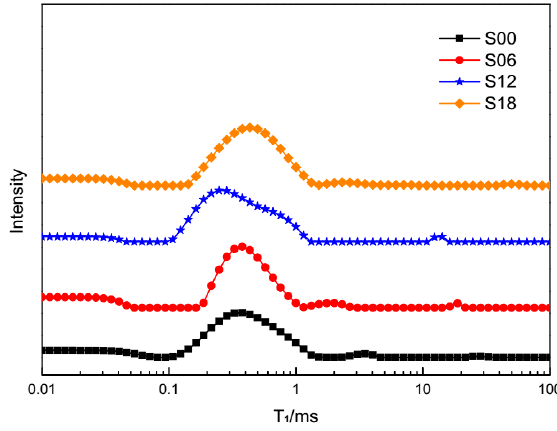
ff erent cement pastes at 605 min. Materials 2020 , 11 , x FOR PEER REVIEW